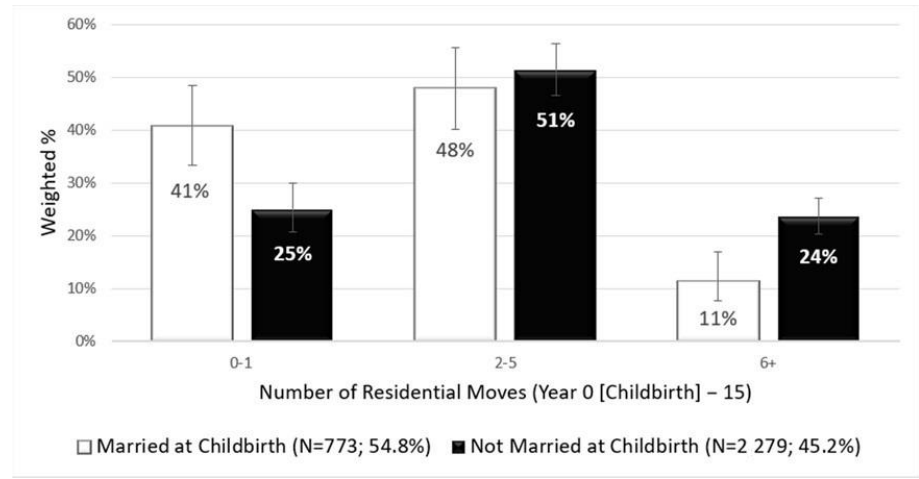
Figure 1. Number of 15 – year cumulative residential moves among U.S. mothers by marital status at childbirth, Fragile Families and Child Wellbeing Study (n = 3052).